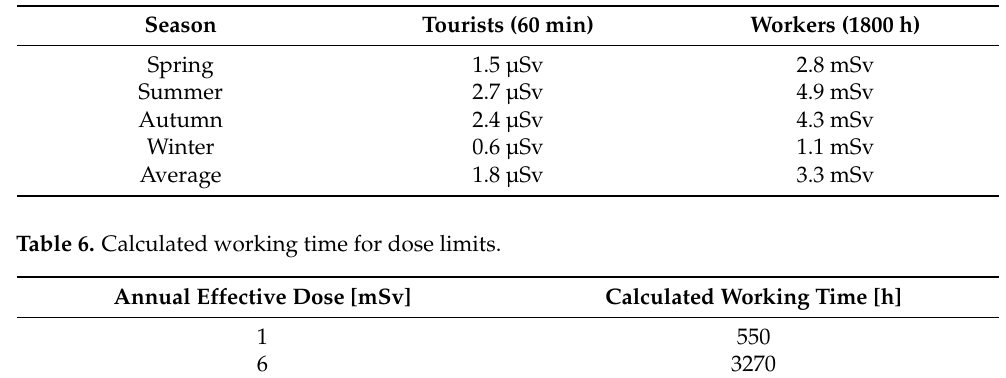
Table 5. Effective dose for different exposure period.